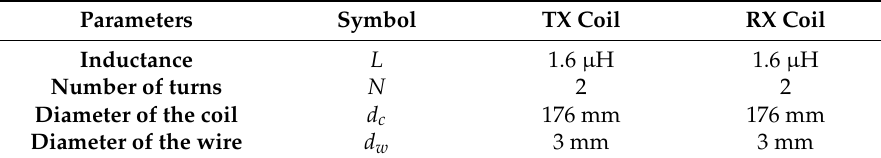
Table 2. Parameters of the primary and secondary side coils L 1 and L 2 .